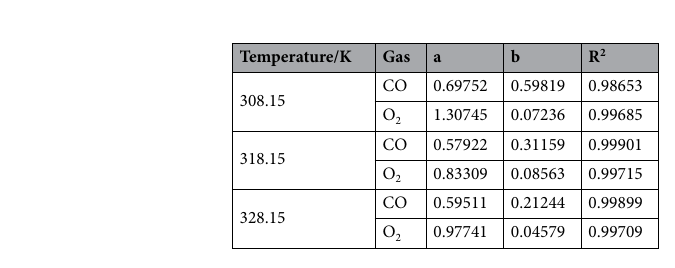
Table 4. Langmuir fitting parameters of single-component adsorption at different